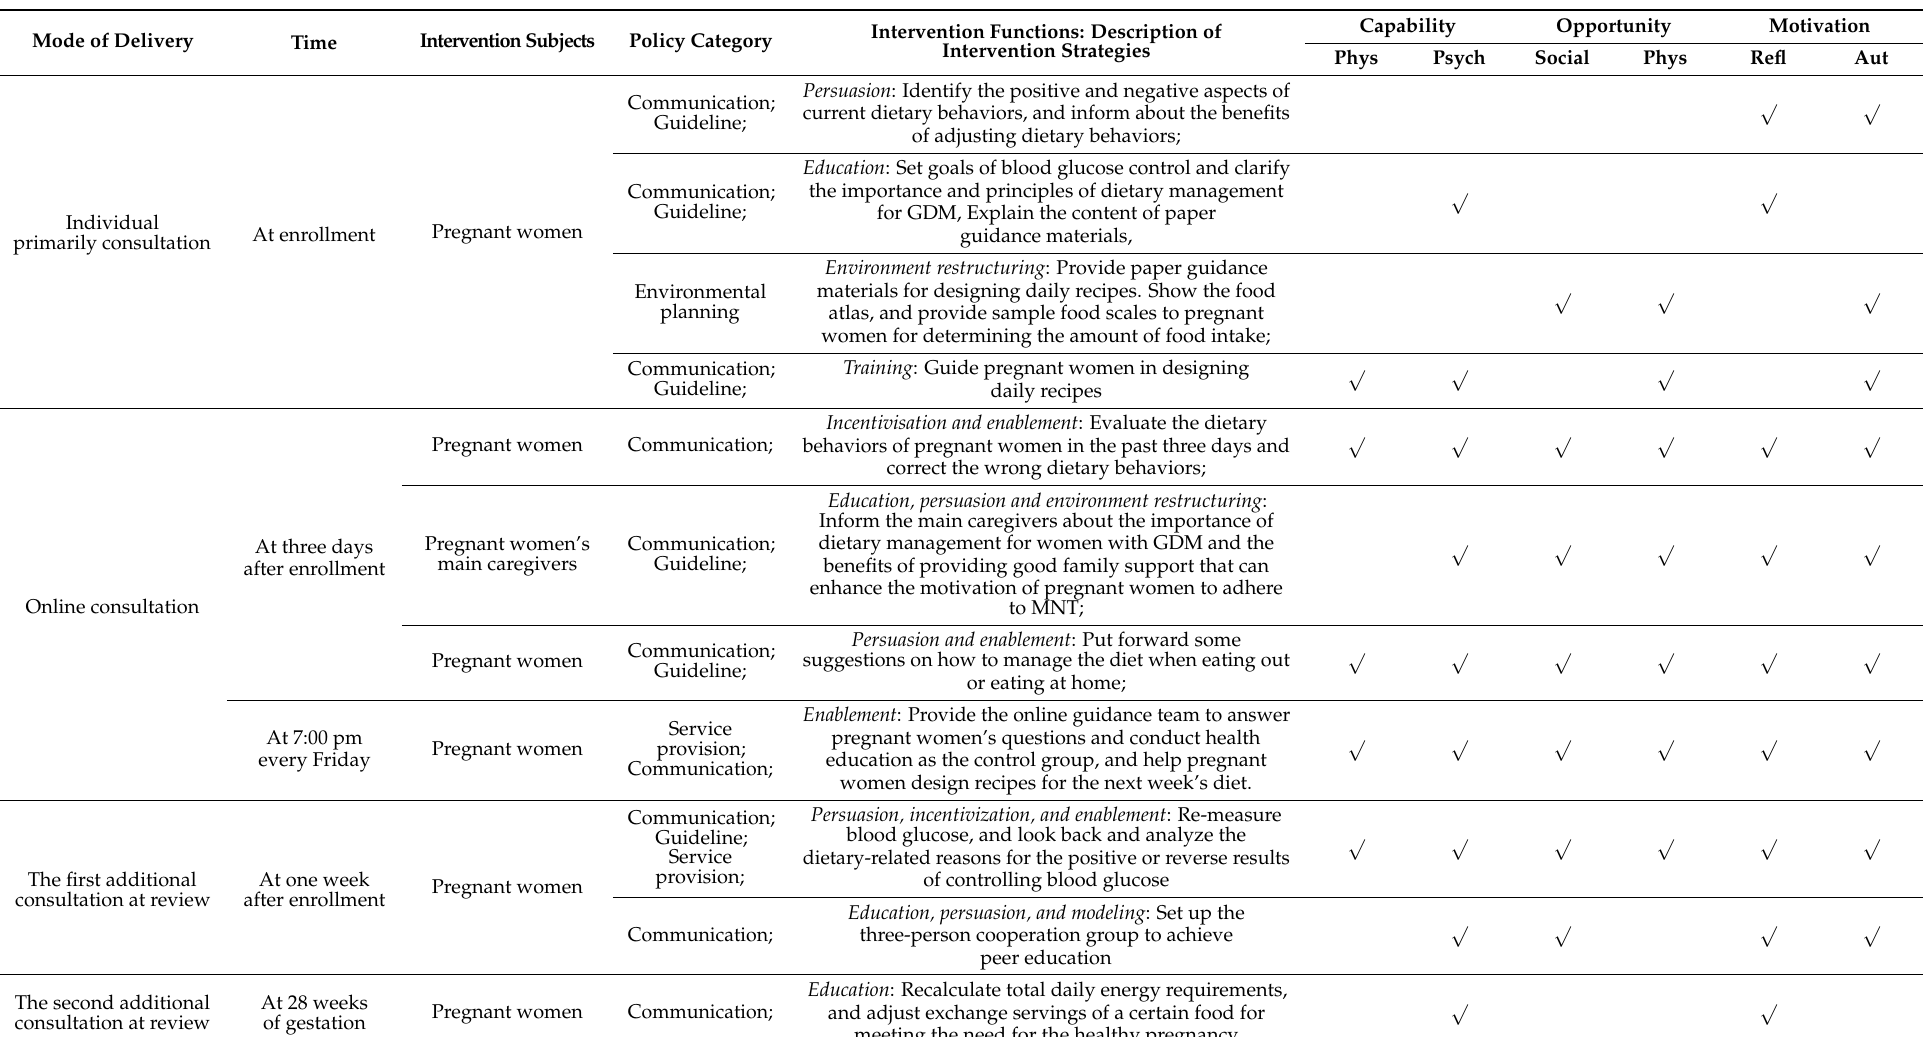
Table 1. Matrix of links between the components of the BCW model (COM-B model, intervention functions, and policy category) for the